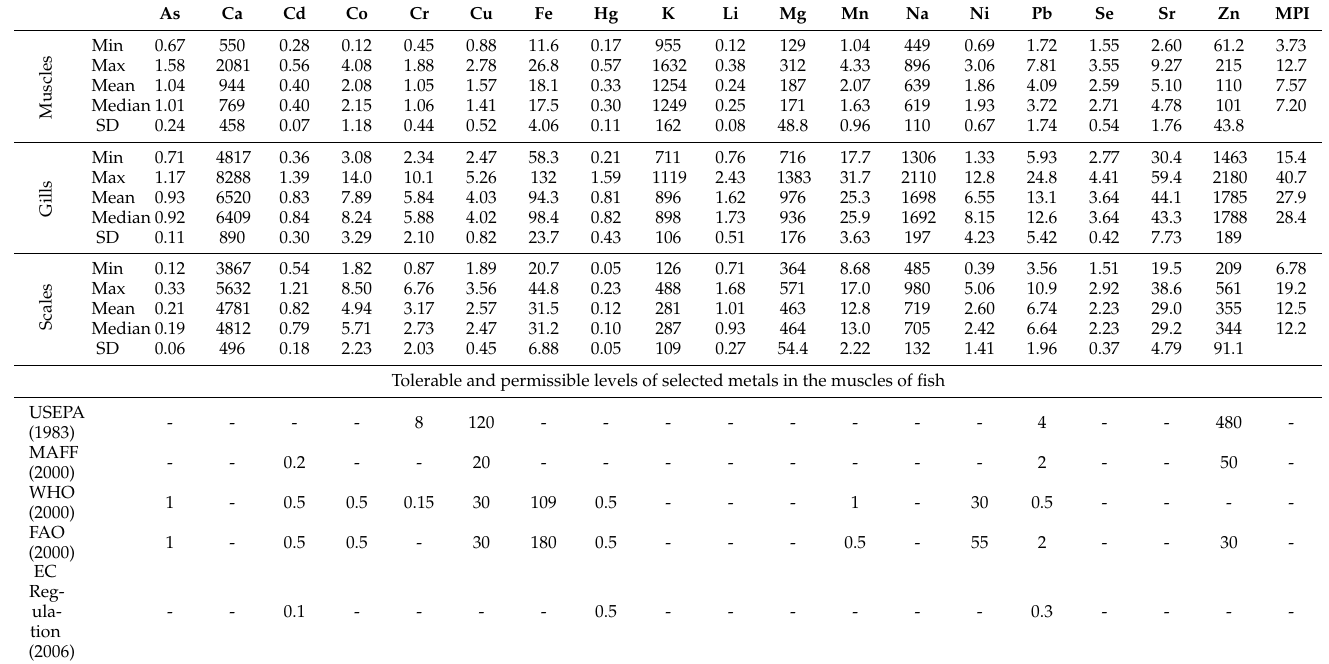
Table 2. Statistical summary of selected metal distribution ( µ g/g) and metal pollution index (MPI) in various tissues of Catla catla